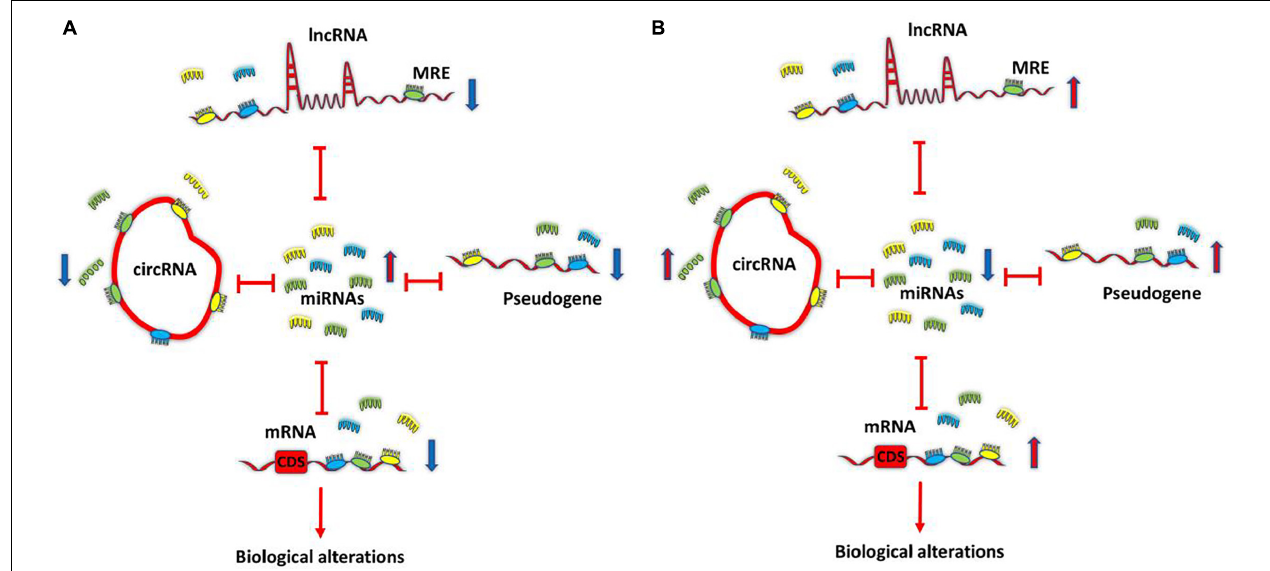
FIGURE 1 | Competing endogenous RNA (ceRNA) model. All transcriptome components, such as long non-coding RNAs (lncRNAs), circRNAs, pseudogenes, and mRNAs that share common MRE, can function as ceRNAs and can co-regulate each other by sponging shared miRNAs. Differentially expressed transcripts can lead to ceRNA dysregulation and biological alterations. ceRNA. (A) Down-regulation of ceRNAs increases the amounts of free miRNAs, thereby repressing target expression. (B) Conversely, up-regulation of ceRNAs reduces free miRNAs abundance, thereby derepressing target expression. Competing endogenous RNA; circRNA, circular RNA; lncRNA, long non-coding RNA; miRNA, microRNA; MRE, miRNA response